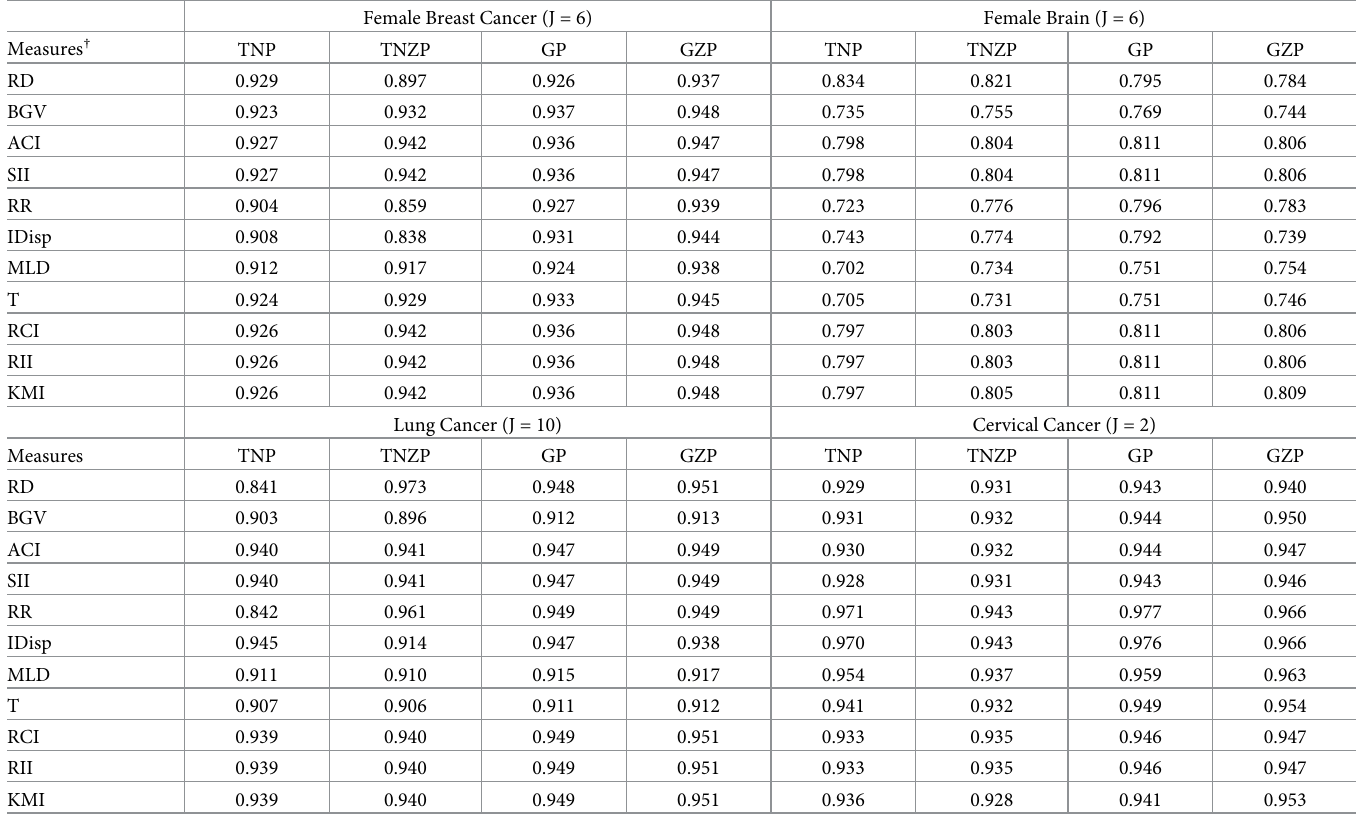
Table 2. The coverage probabilities (CP) are compared with nominal coverage .95 for 11 health disparity measures under the four scenarios: The truncated normal distribution with standard Poisson sampling (TNP), the truncated normal distribution with zero-inflated mean implemented Poisson sampling (TNZP), the gamma distribution with standard Poisson sampling (GP), and the gamma distribution with zero-inflated mean implemented Poisson sampling